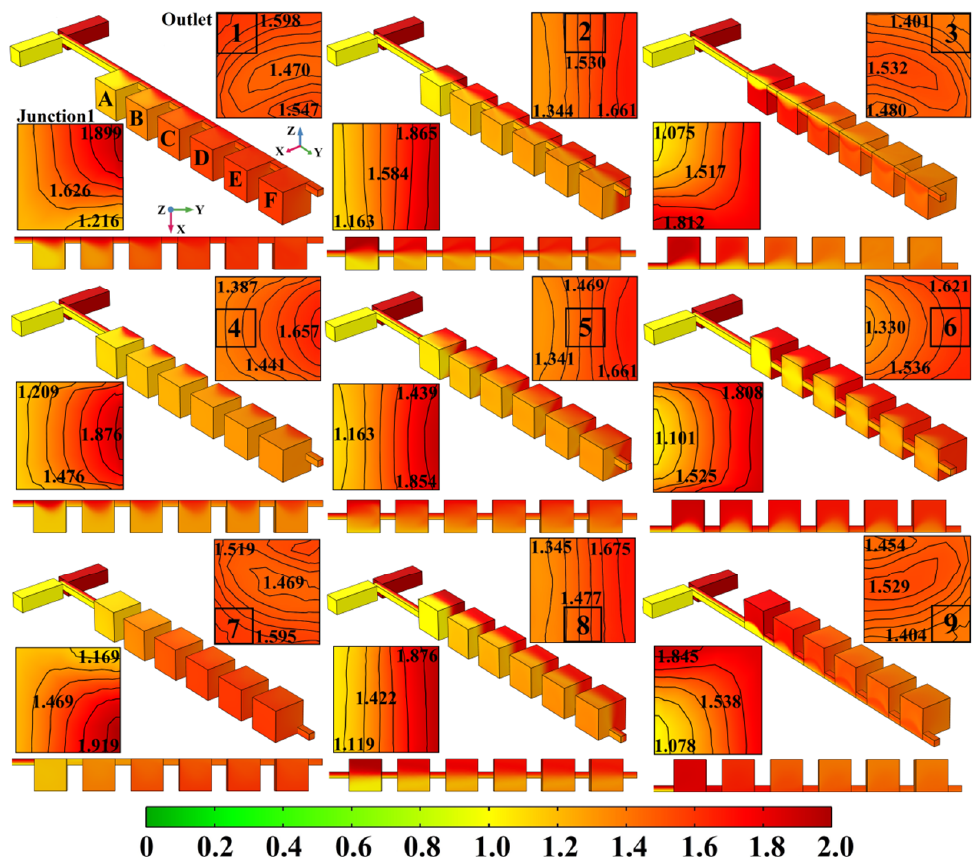
Figure 4. The 3D view, top view and cross-sectional concentration distributions of micromixers with different junction locations.